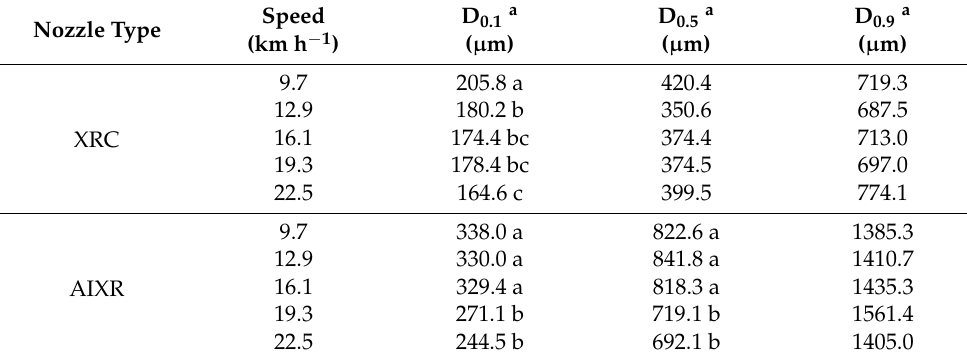
* represents significant effects ( p < 0.05) and NS represents non-significant effects ( p > 0.05). XRC, AIXR, and TTI denote TeeJet ® extended range, air induction extended range, and turbo-teejet induction nozzle types, respectively. Table 7. Influence of ground speed on D 0.1 , D 0.5 , and D 0.9 by nozzle type for CNS. D 0.1 , D 0.5 , and D 0.9 are the droplet diameters ( µ m) where 10%, 50%, and 90%, respectively, of the spray volume is contained in the spray droplets smaller than this value. CNS represents the sprayer without a rate